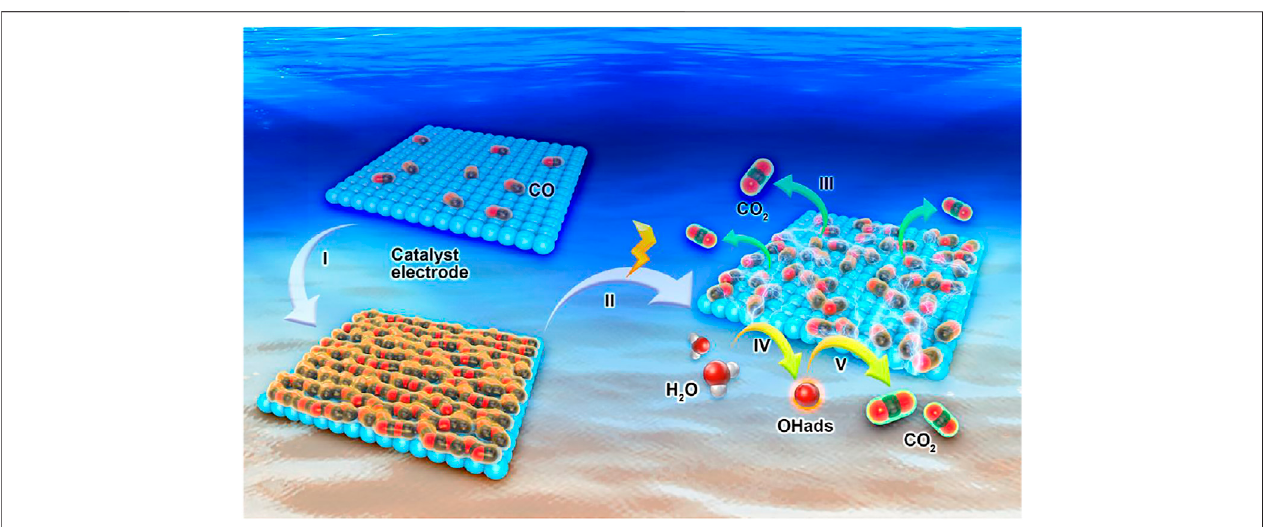
FIGURE 4 | Scheme of the CO adsorption